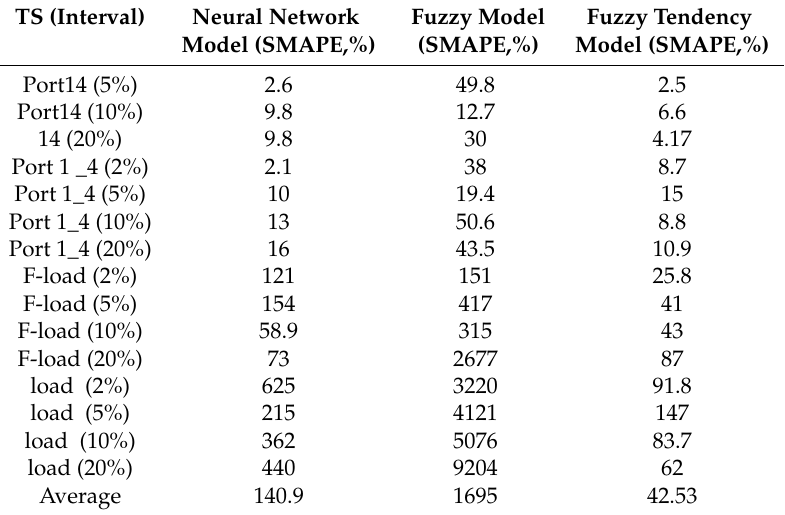
Table 12. The results of the quality indicators of models in the short-term forecasting of the volume and trends of computer network